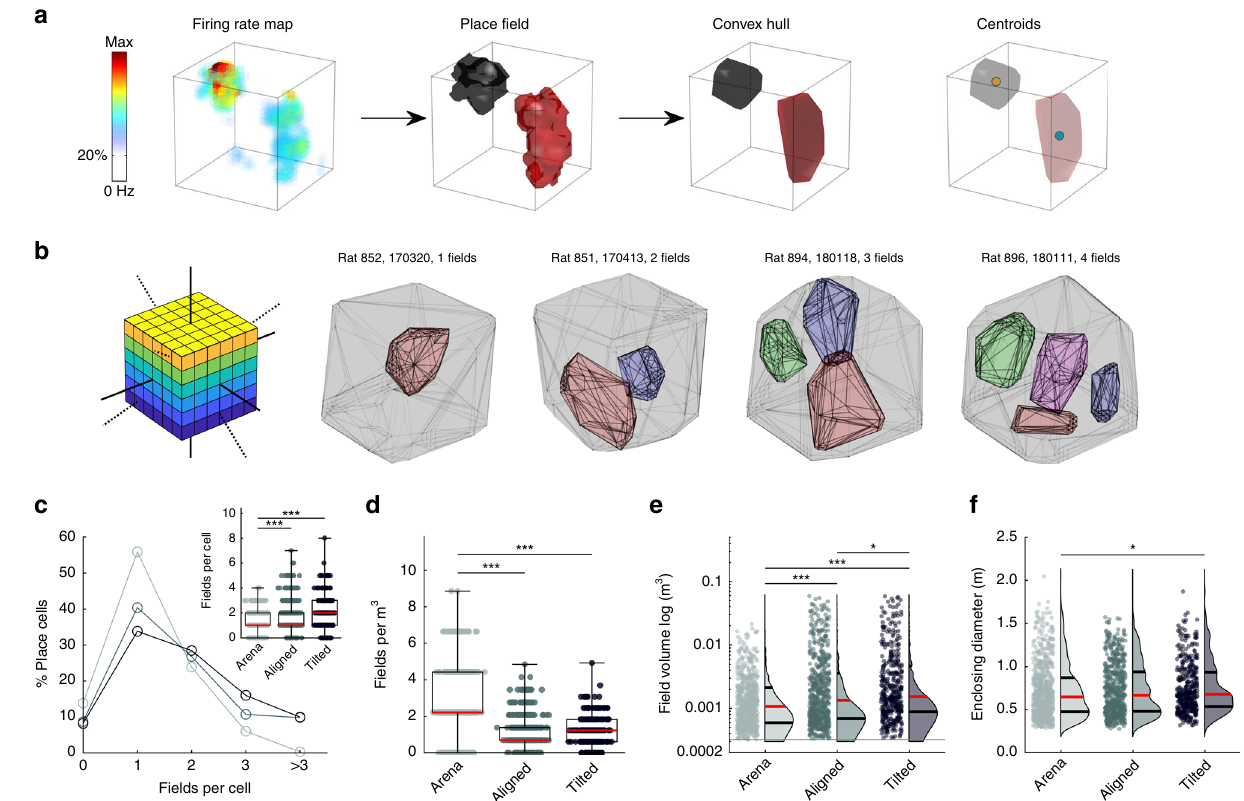
Fig. 10d, Supplementary Data: Comparison of fi ring properties between mazes ).